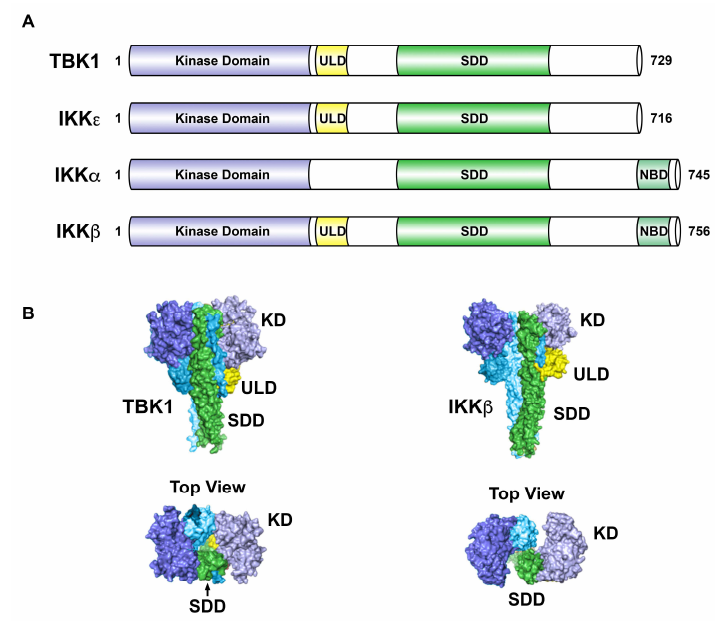
Figure 2. Structural comparison of IKK-related kinases. ( A ). The kinase domain of IKKε shares 27% identity with IKKα and 24% identity with IKKβ. TBK1 shares 49% identity and 65% similarity with IKKε. ( B ). Surface views of TBK1 (left panels) and IKKβ (right panels), with corresponding domains colored in TBK1 and IKKβ. In TBK1, the ULDs bridge between dimer SDDs, but extend away from the opposite SDDs in IKKβ. The kinase domains in the IKKβ dimer are differently oriented and do not form dimer contacts. The IKKβ structure is drawn from Protein Data Bank ID code 3QA8 [28]. The TBK1 structure is drawn from Protein Data Bank ID code 4IM0 [29]. TBK1, TANK-binding kinase 1; IKK, IκB kinase; KD, kinase domain; ULD, ubiquitin-like domain; SDD, scaffold dimerization domain; NBD, NEMO-binding domain. Adapted from [5,29,30].